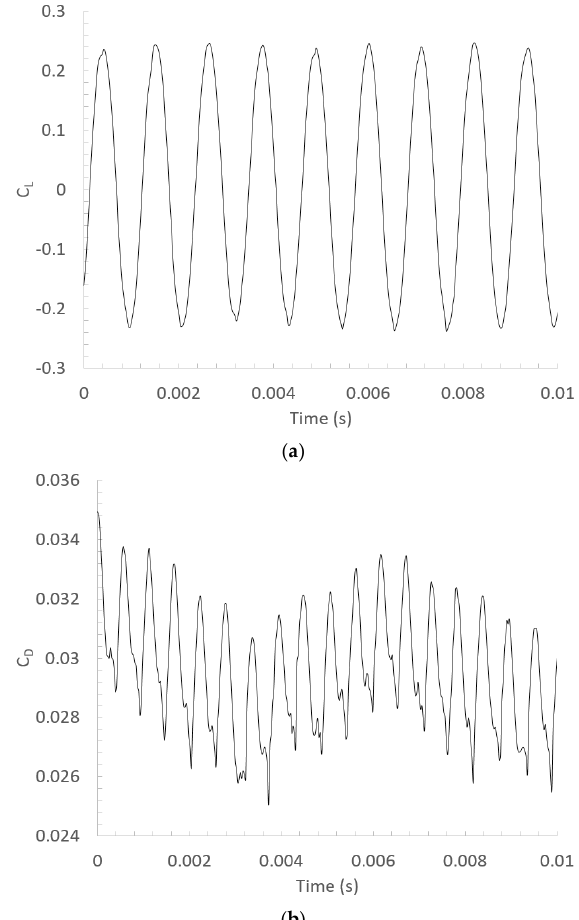
Figure 4. Time histories of the C L ( a ) and C D ( b ) for the developed condition.